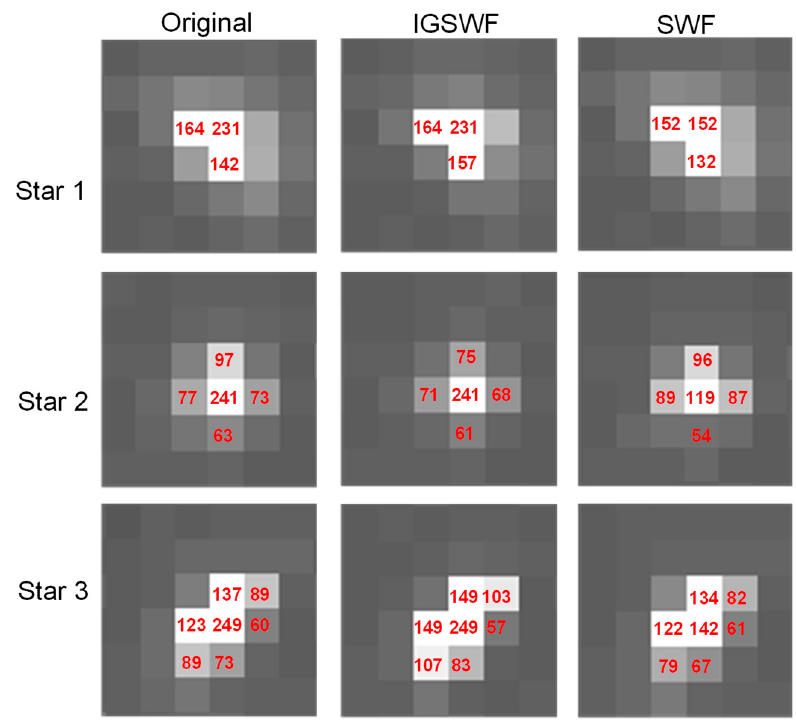
Figure 13. Comparison of the IGSWF algorithm with Gaussian filtering, box filtering, and mean filtering: ( a ) before denoising; ( b – e ) after denoising by the IGSWF algorithm, Gauss ‐ ian filtering, box filtering, and mean filtering, respectively. The first lines are star images, the second lines are the three ‐ dimensional distribution of the grayscale in the star image, and the third lines are the local star points.